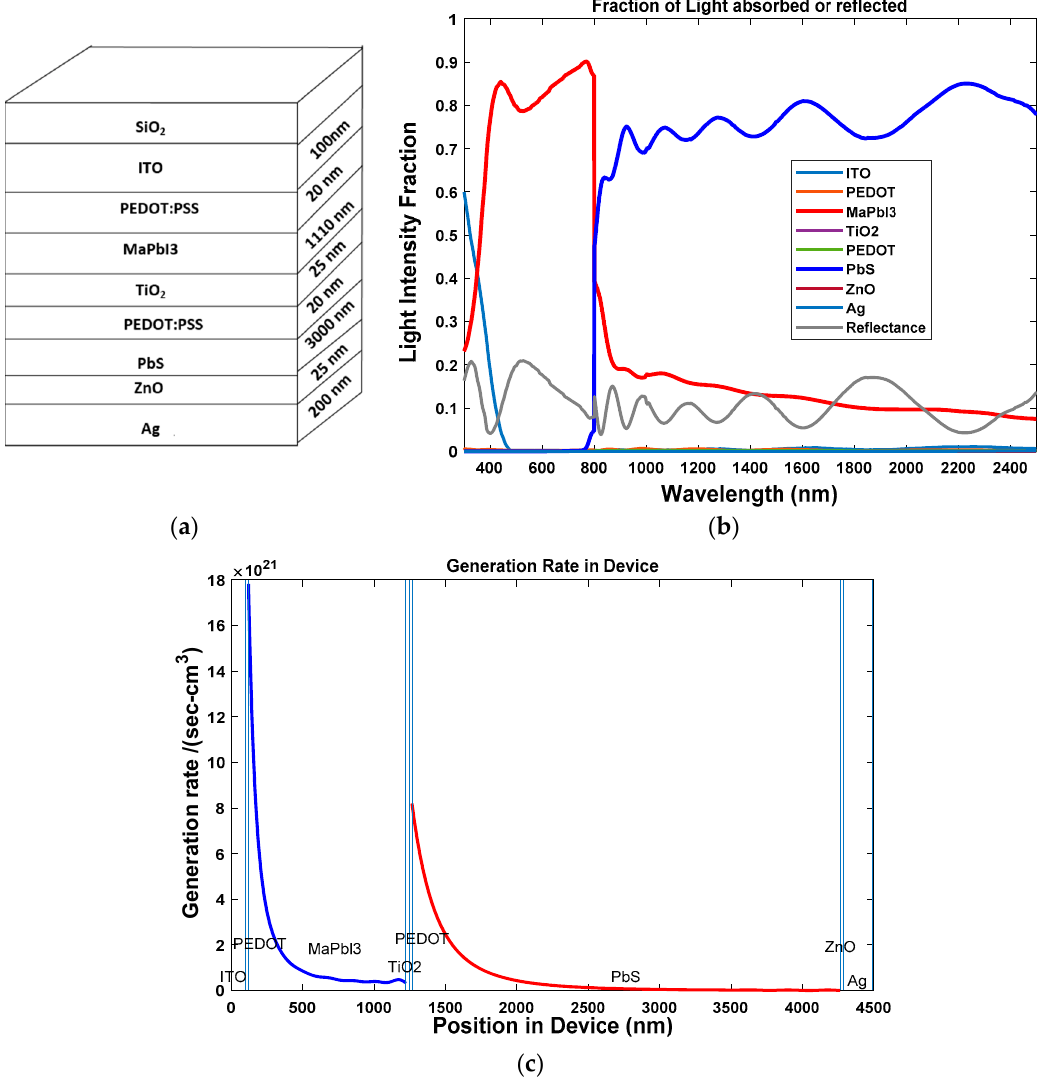
Figure 8. ( a ) Stack diagram; ( b ) variation of light intensity versus wavelength for HSC MaPbI 3 and rear PbS active layers; and ( c ) exciton generation rate vs. position of device for two-junction hybrid solar cell.